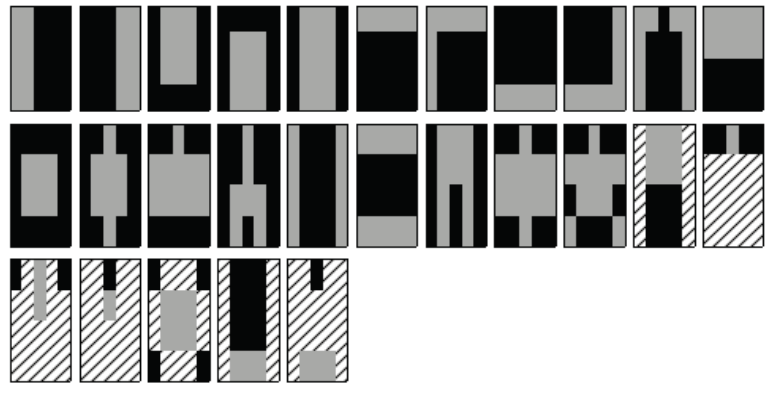
exist within the gray polygon is subtracted from the sum of the pixels in the black polygon. The areas with the dashed lines indicate insignificant